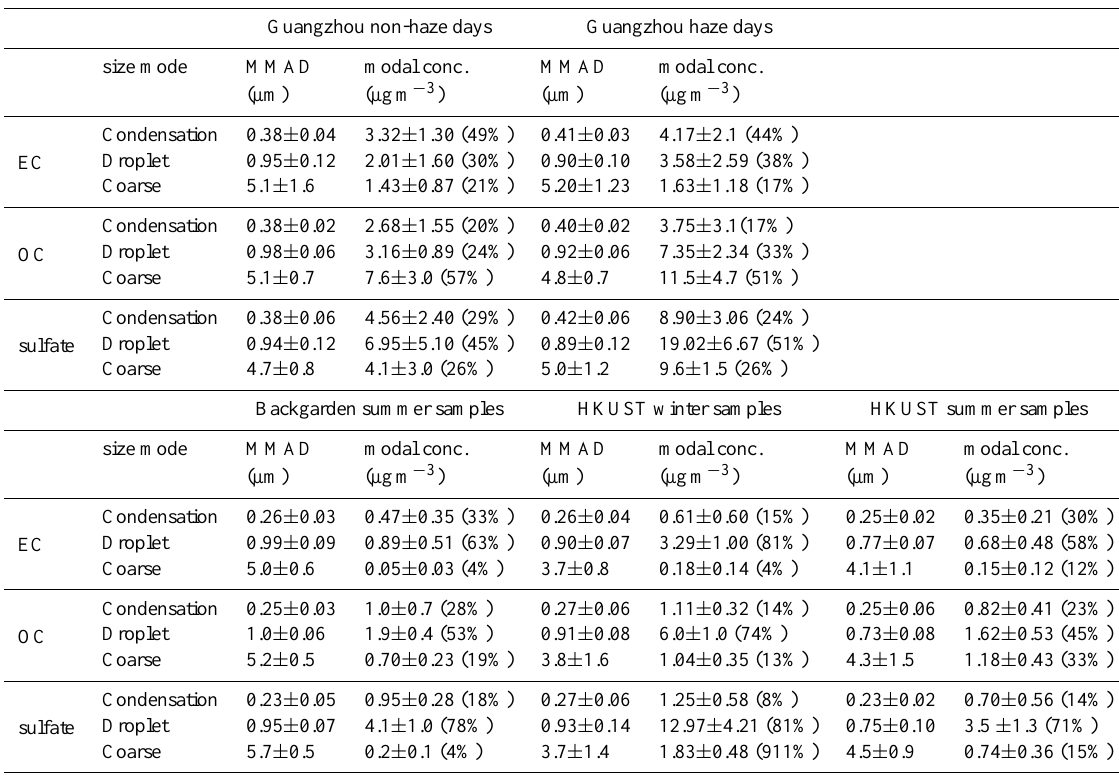
Fig. 2. Mean elemental carbon size distributions in five groups of samples. From top left to bottom right: Guangzhou urban samples on non-haze days, Guangzhou urban samples on haze days, Backgarden summer samples, HKUST winter samples, and HKUST summer samples. Table 2. MMAD values and modal concentrations of EC, OC, and sulfate in the urban, suburban and rural samples collected in the pearl river delta